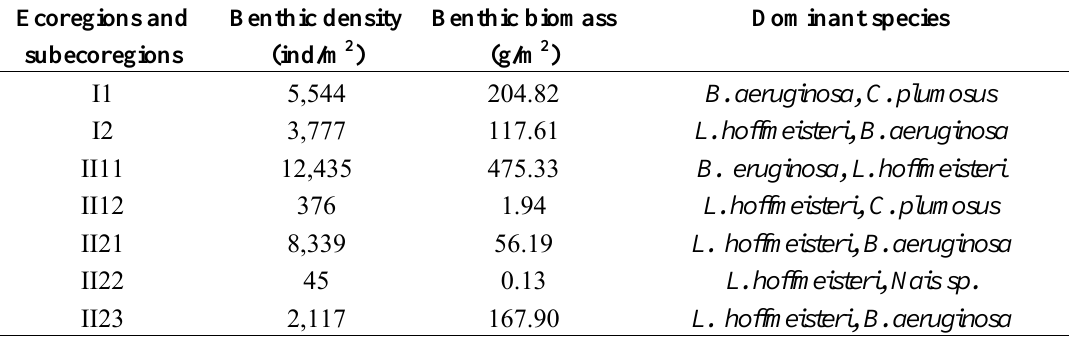
Table 5. Characteristics of benthic animals in different aquatic ecoregions and subecoregions in Taihu Lake watershed.